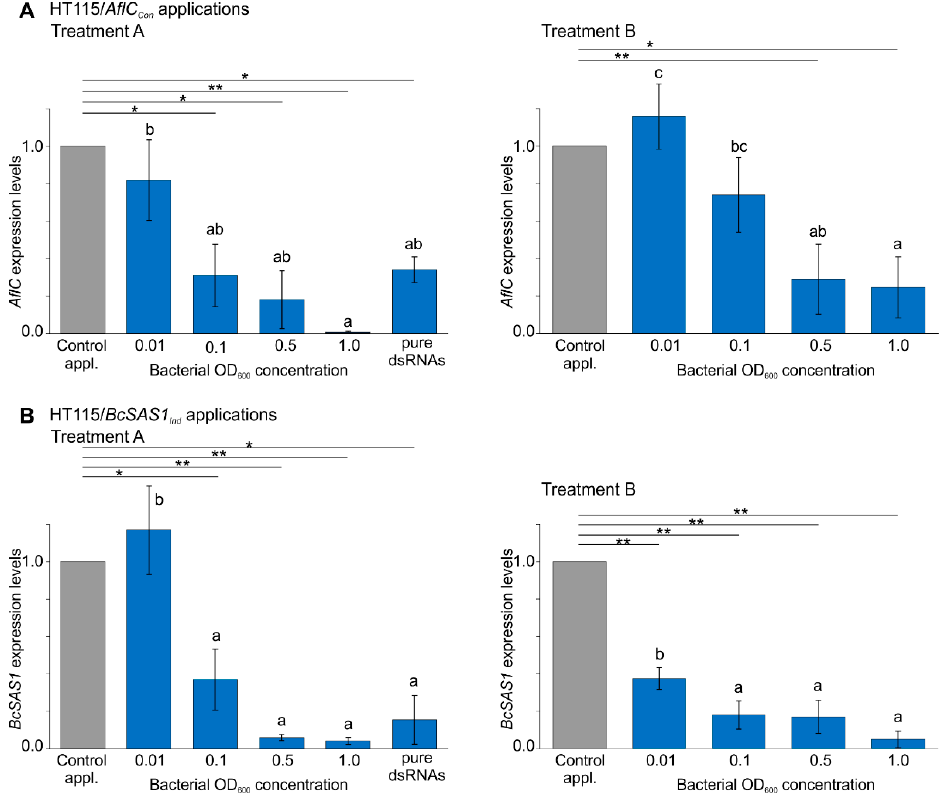
Figure 2. Bacterially-produced dsRNAs induce RNAi in fungi in a bacteria concentration-dependent manner. ( A , B ) Ex- pression levels of AflC from A. flavus (Panel A) and BcSAS1 from B. cinerea (Panel B), in in vitro cultures of the fungi with living (Treatment A) or lysed (Treatment B) E. coli HT115(DE3) bacteria producing dsRNAs against AflC (HT115/ AflC Con ) or BcSAS1 (HT115/ BcSAS1 Ind ), respectively (test applications; blue bars). Expression levels are shown relative to the ex- pression of AflC and BcSAS1 when A. flavus and B. cinerea are co-incubated with the control HT115(DE3) bacteria produc- ing dsRNAs against eGFP (HT115/ eGFP Con and HT115/ eGFP Ind, respectively) (control applications; grey bars set to 1.0). Liv- ing bacteria or their whole-cell autolysates, obtained from the OD 600 0.01, 0.1, 0.5, and 1.0 cultures were added to the fungal cultures, and the expression of AflC or BcSAS 1 was measured at 12 h of co-incubation. For comparison, AflC and BcSAS1 silencing levels achieved by the addition in the in vitro cultures of A. flavus or B. cinerea of 15 μ g (12.5 nM) of purified dsRNAs against each gene, respectively were also evaluated. Significant differences between control and test applications were determined by a one-way ANOVA followed by a Tukey’s HSD test, and levels of significance are indicated above the bars by underlined star symbols (i.e., * p < 0.05, ** p < 0.01). Differences in the gene silencing efficacy of AflC and BcSAS1 among the test applications were tested by ANOVA and Tukey’s HSD test, and significantly different groups ( p < 0.05) are indicated by letters above the bars. Error bars in the figure indicate standard deviation (SD) obtained from three bio- logical replicates.